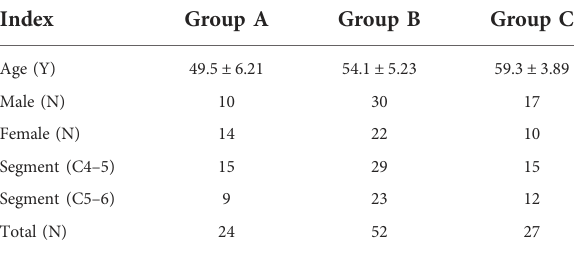
TABLE 1 Comparison of baseline characteristics of patients between three